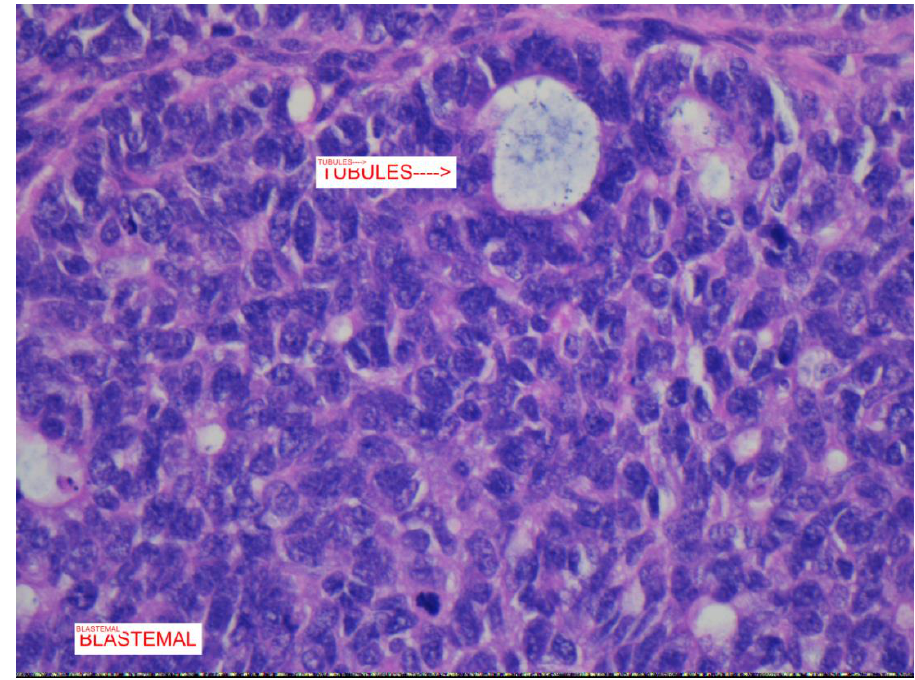
Figure 4. Microscopic features of adult Wilms’ tumour showing blastemal elements.